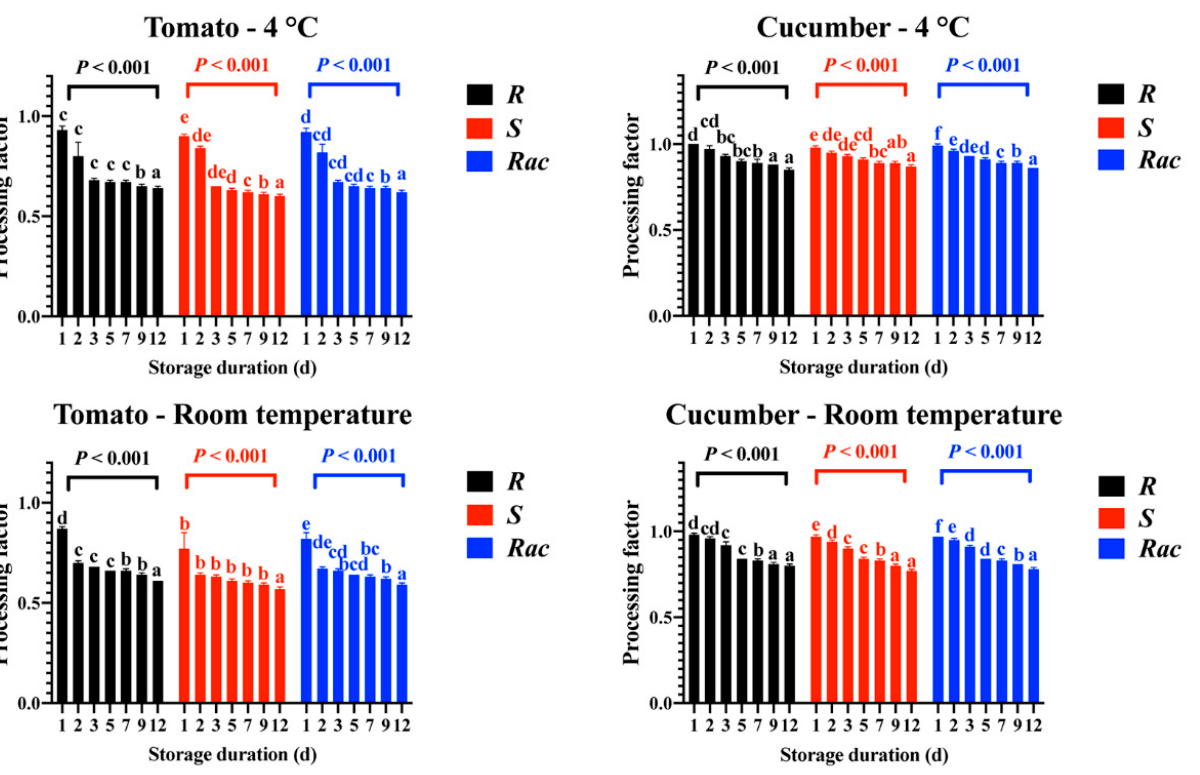
Figure 3. PF values of R -, S -, and Rac -penthiopyrad in tomato sauce and cucumber juice samples after storing at different durations under 4 °C and room temperature. Each lowercase letter indicates significant differences between the six sampling intervals by Duncan’s multiple range test ( p = 0.01).